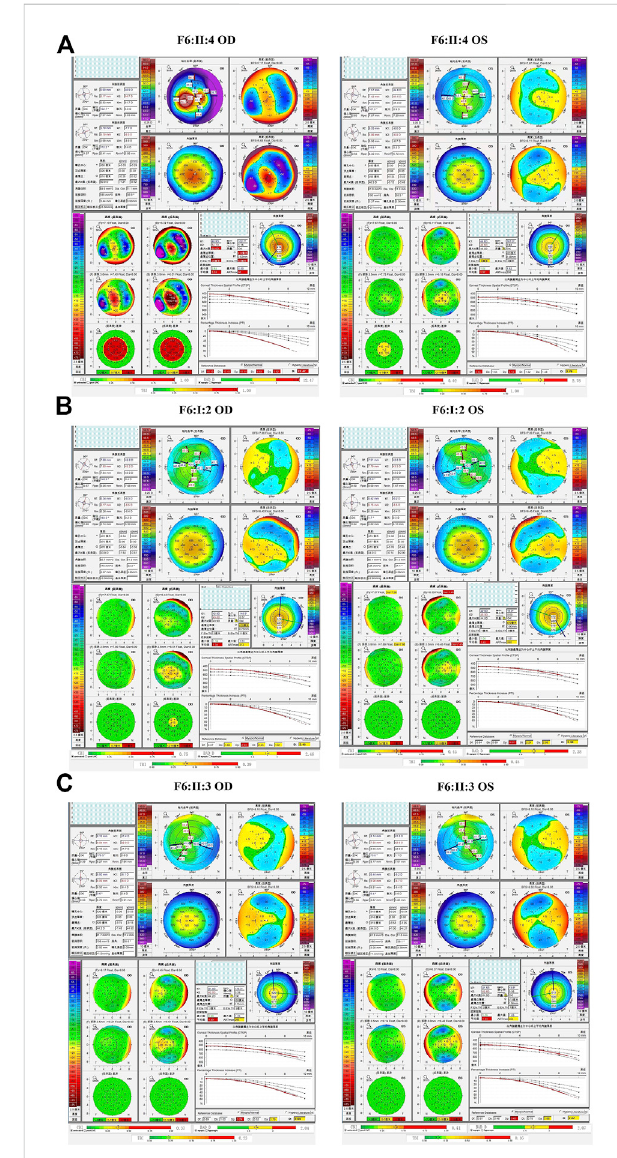
FIGURE 8 Pentacam and Corvis ST images of the proband and asymptomatic fi rst-degree relatives carrying the p.R27R variant in F5. (A) Abnormal corneal topography and biomechanics of the proband. (B) Pentacam and Corvis ST examinations of the father with the variant revealed two suspicious parameters (Db and TBI) in the right eye, while four suspicious parameters (B.Ele.Th, Db, BAD-D and TBI) were detected in the left eye. (C) Pentacam and Corvis ST examinations of the brother with the variant revealed four suspicious parameters (ARTmax, Da, BAD-D, and TBI) and two abnormal parameters (Dp, and CBI) in the right eye, while one suspicious parameter (Dp) was detected in the left eye.